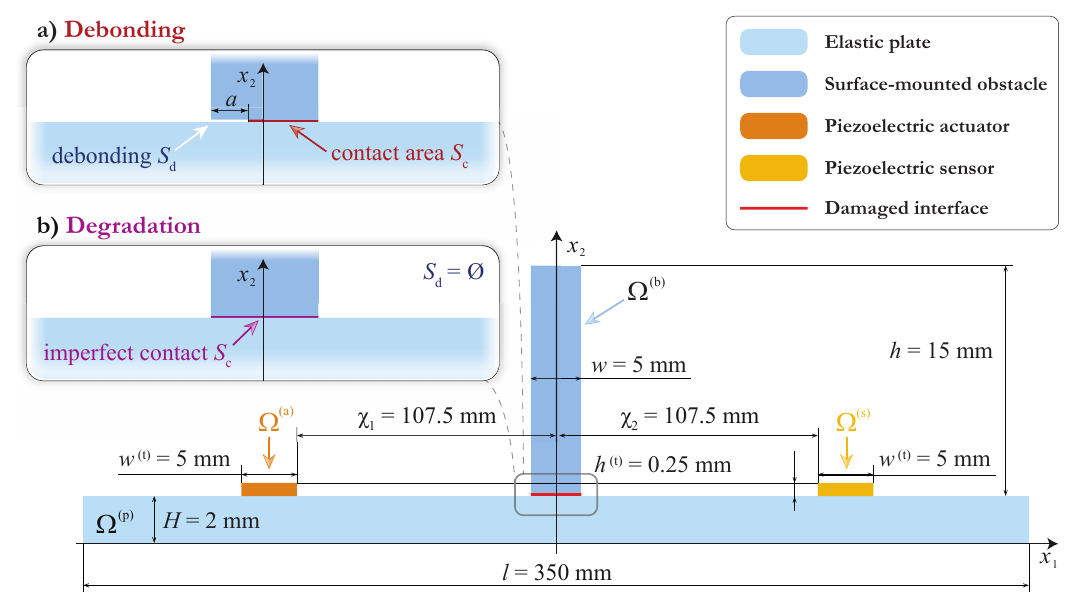
Figure 16. The geometry for the mathematical